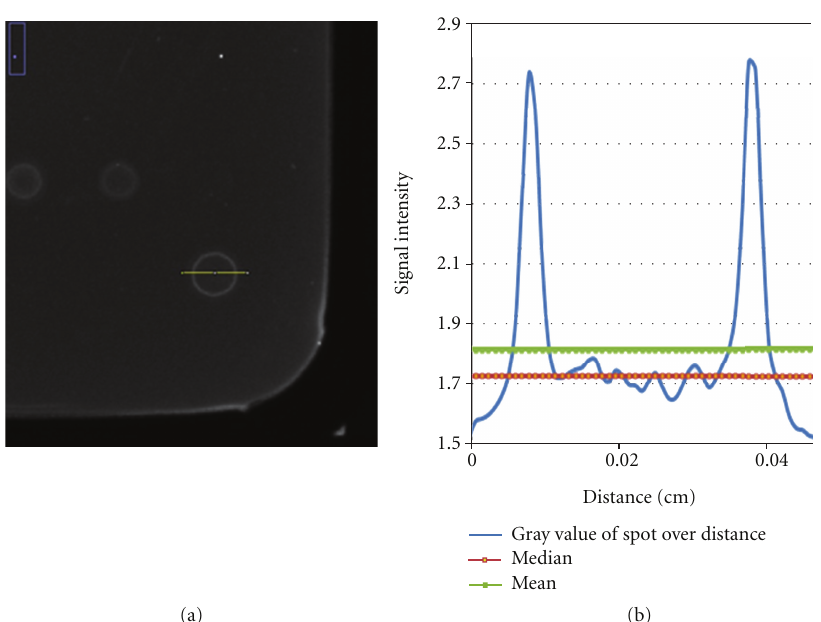
Figure 5: Mean versus median spot intensity for donut structures. Left-hand picture shows a protein spot with a typical donut structure (orange line indicates the intensity intersection). Right-hand side: the intensity distribution is plotted (red and green line are mean and median signal intensity of the